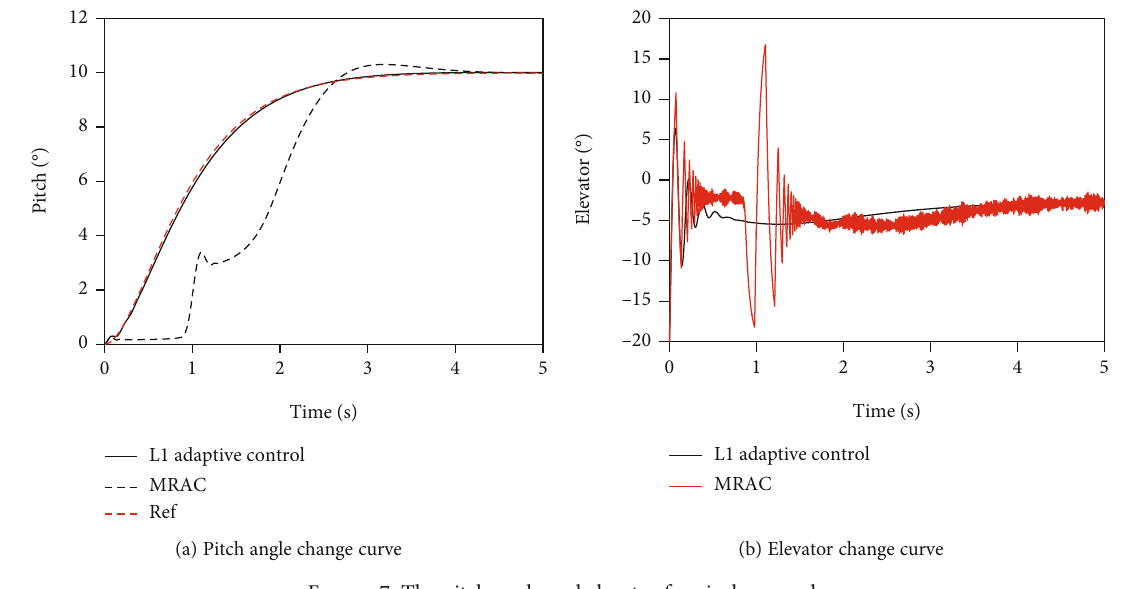
Figure 7: The pitch angle and elevator for airplane mode.